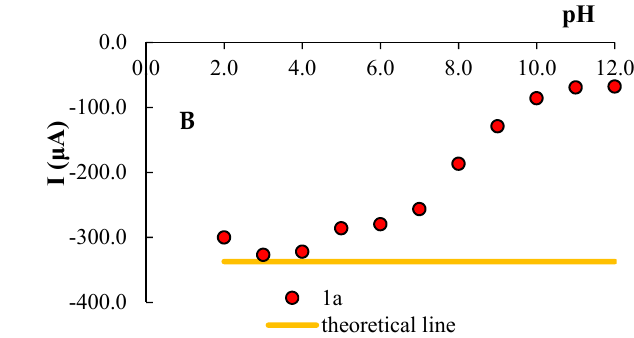
Figure 3. Values of potential ( A ) and current ( B ) of the first peak of the ER 5 mM compound of 1a with a change in the pH of the buffer solution, v = 100 mVs − 1 . Red dots—current calculated by the Rendles–Shevchik equation for irreversible electrochemical reactions involving six electrons. Potentials are measured relative to Ag/AgCl/KCl sat .